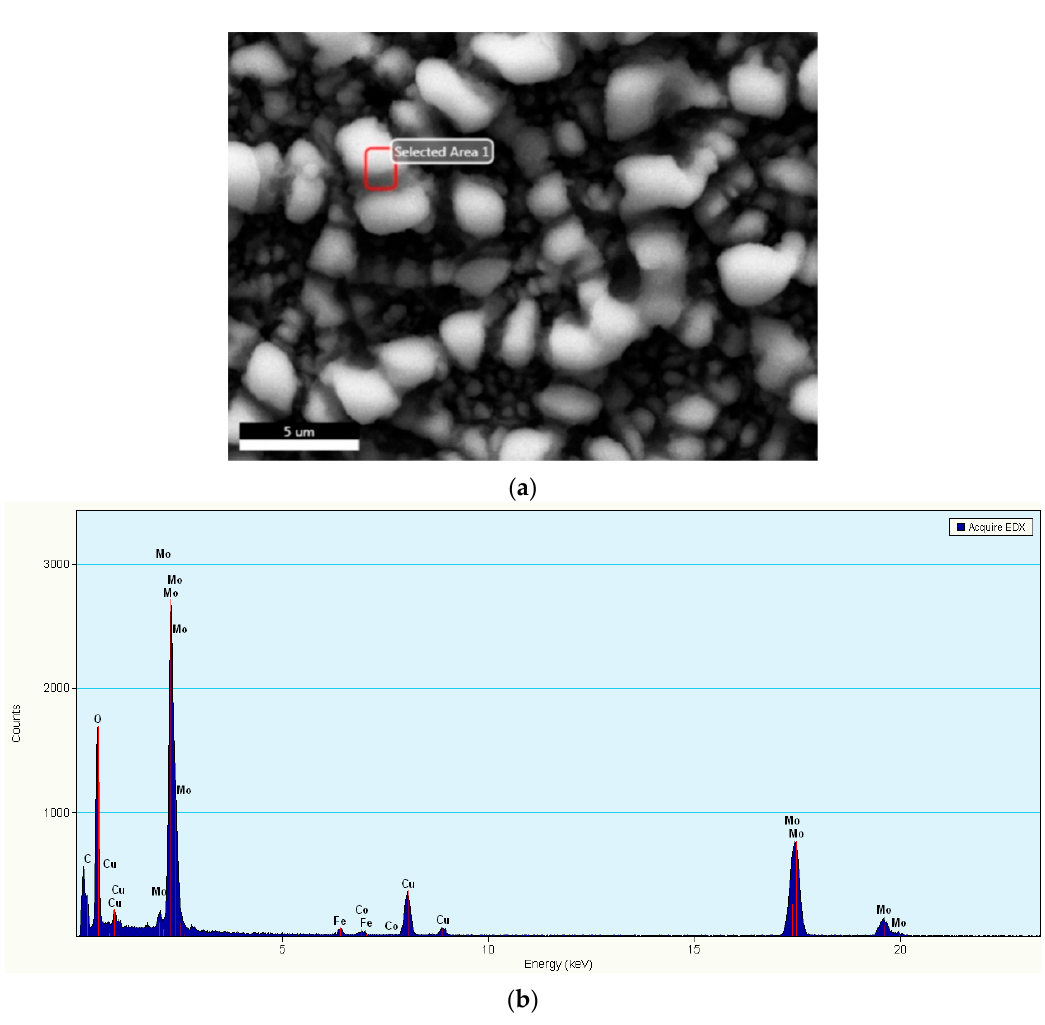
Figure 2. ( a ) Select area for energy-dispersive X-ray analysis (EDAX), ( b ) EDAX spectra of the MoO 3 thin film codoped Fe 2% Co 1% showing the presence of the characteristic elements.